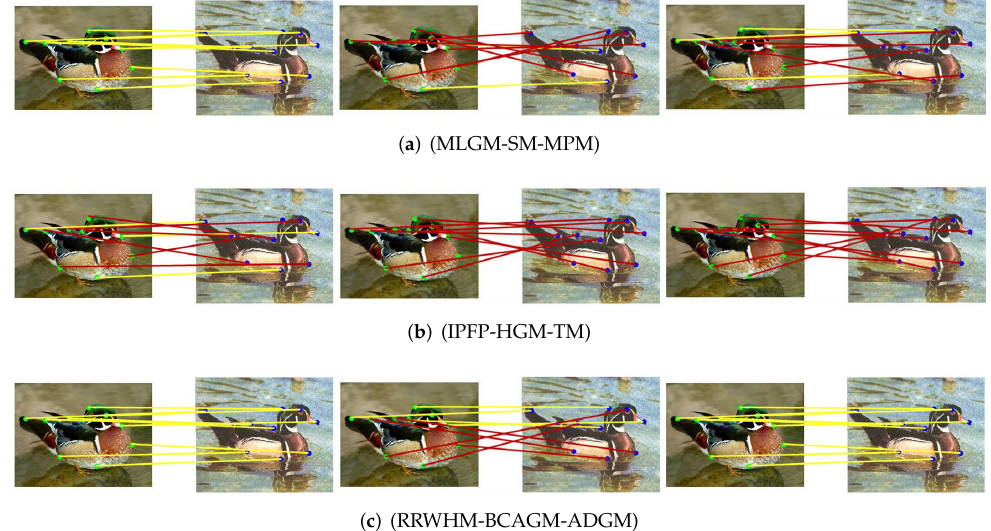
Figure 11. Example results of experiments on the Duck